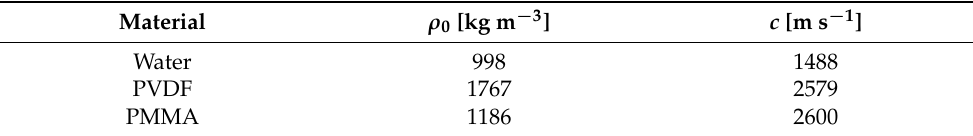
Table 2. The density and wave propagation speed of different materials